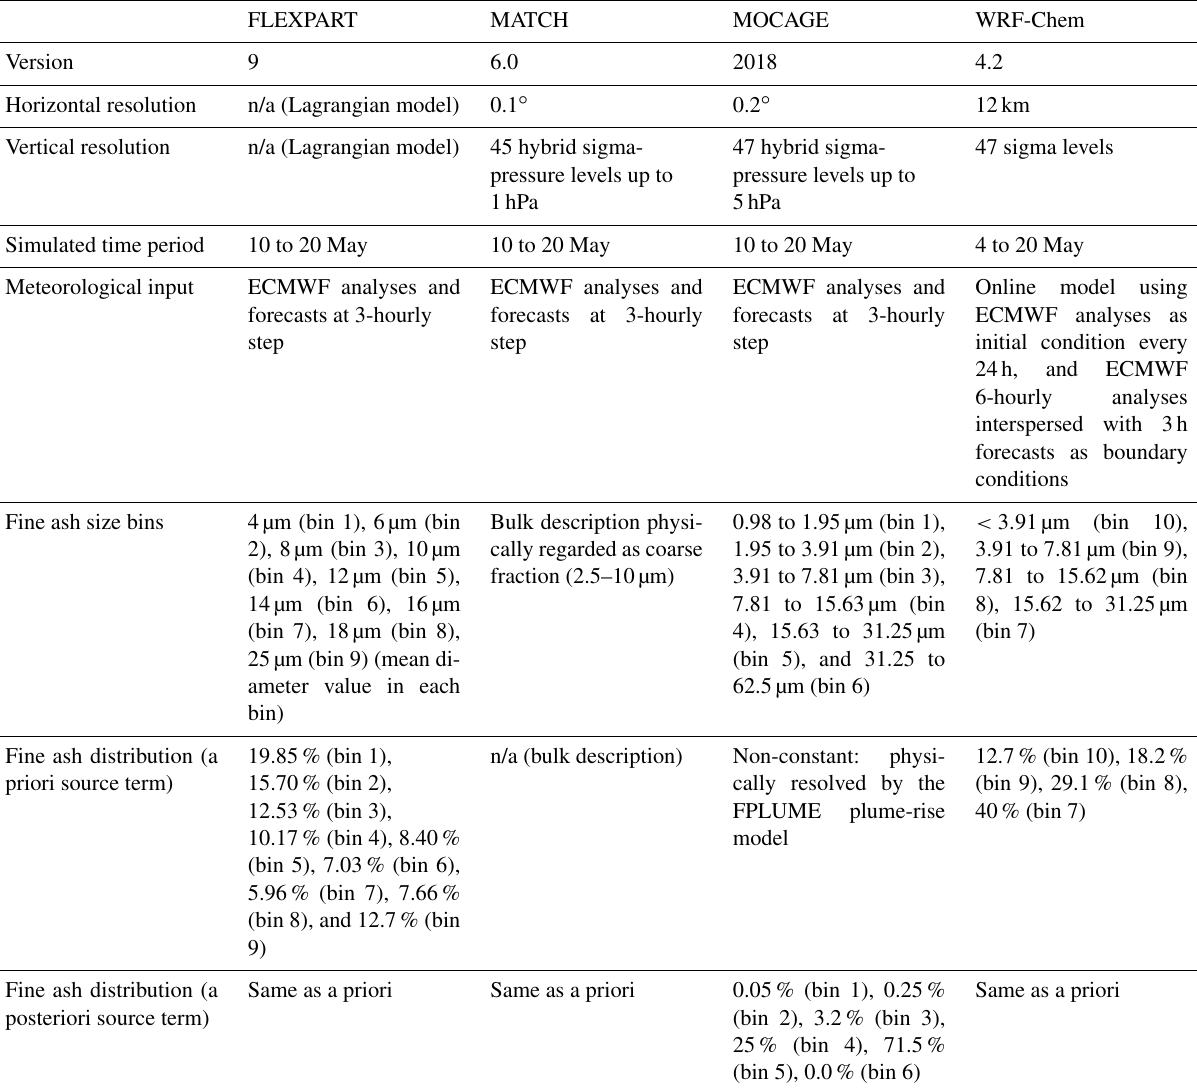
Table 1. Summary of the model configurations used for the model